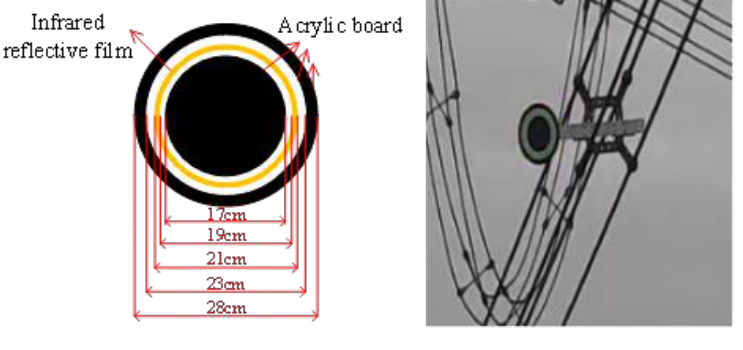
Figure 3. The infrared source label.